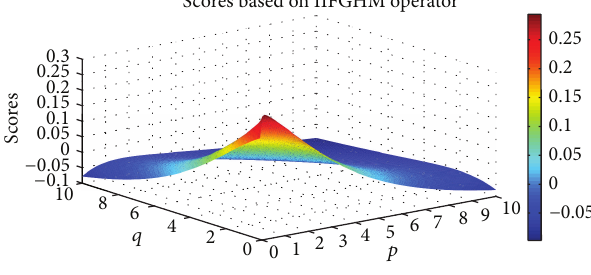
Figure 1: Scores obtained by the IIFGHM operator ( 𝑝 ∈ (0, 10] , 𝑞 ∈ (0, 10] ).